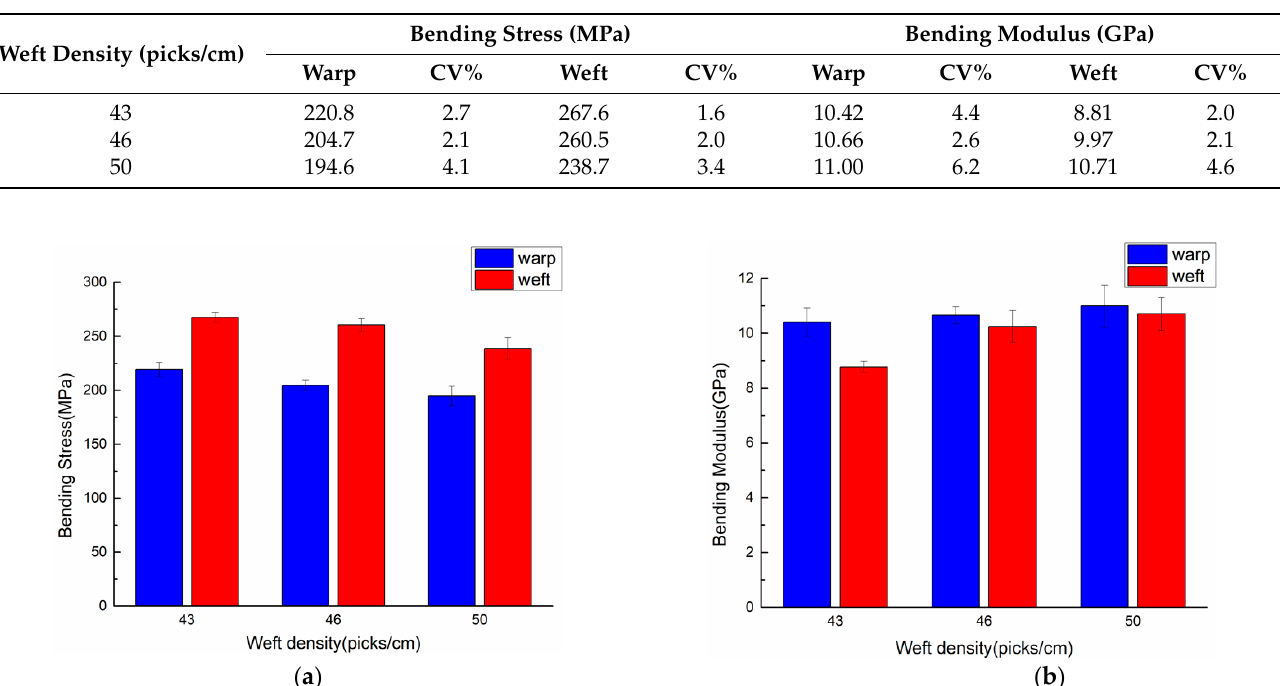
Figure 12. Comparison of the bending properties of materials with different weft densities. ( a ) Bending strength. ( b ) Bending stiffness.